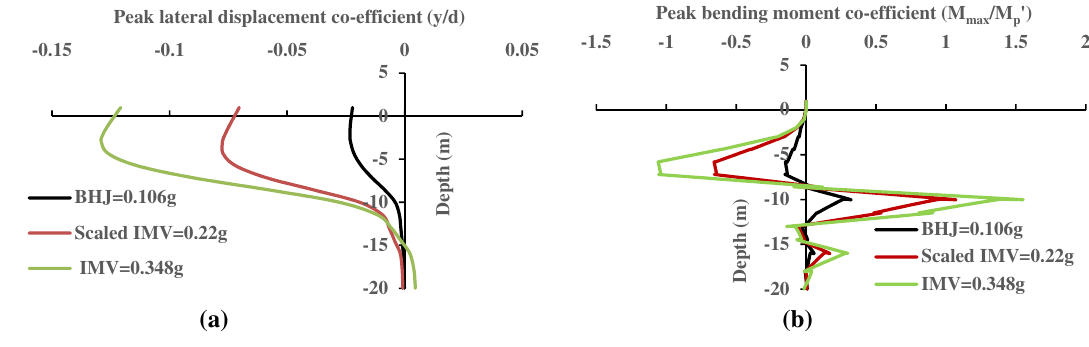
Fig. 13 Kinematic a peak lateral displacement and b peak bending moment of pile in NKD soil under various input motions